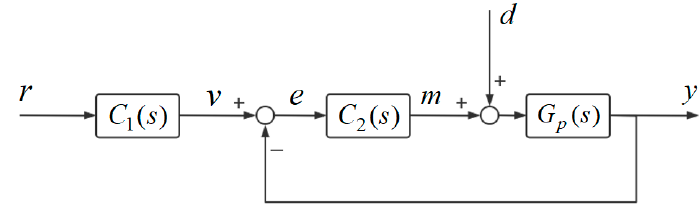
Figure 2. The 2DOF control structure of set-point filter type.